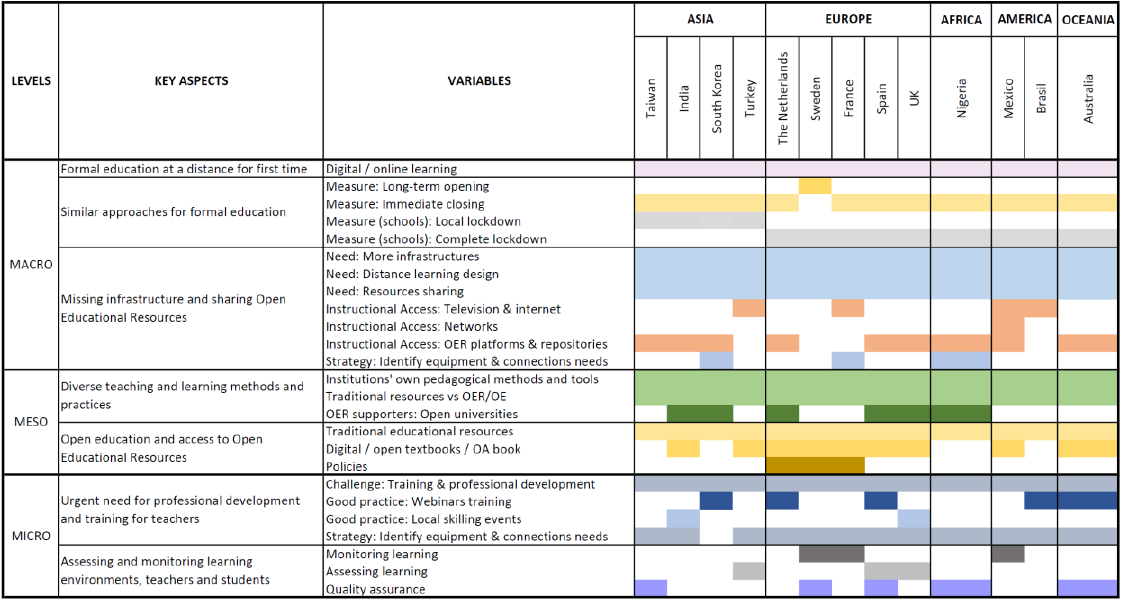
Impact of COVID-19 on Formal Education in 13